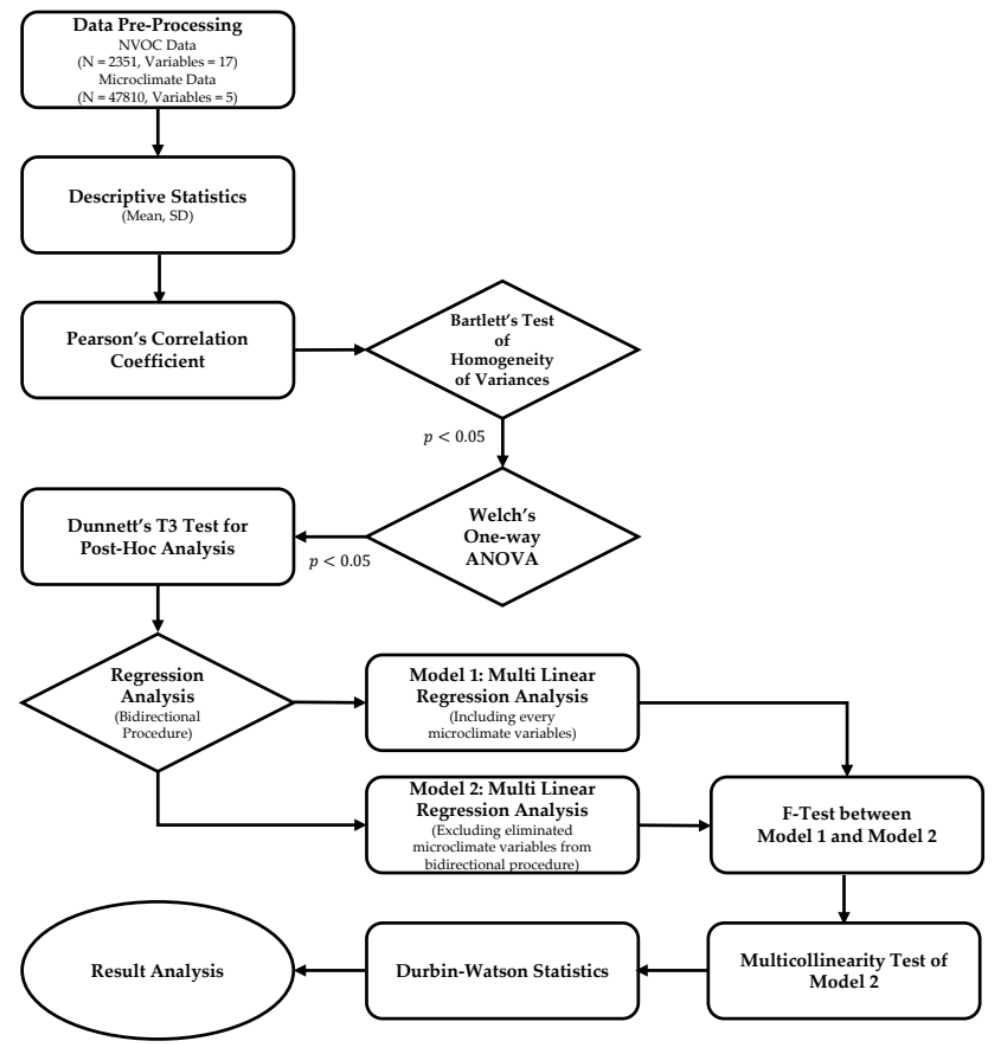
Figure 2. Flow diagram of analysis processes.